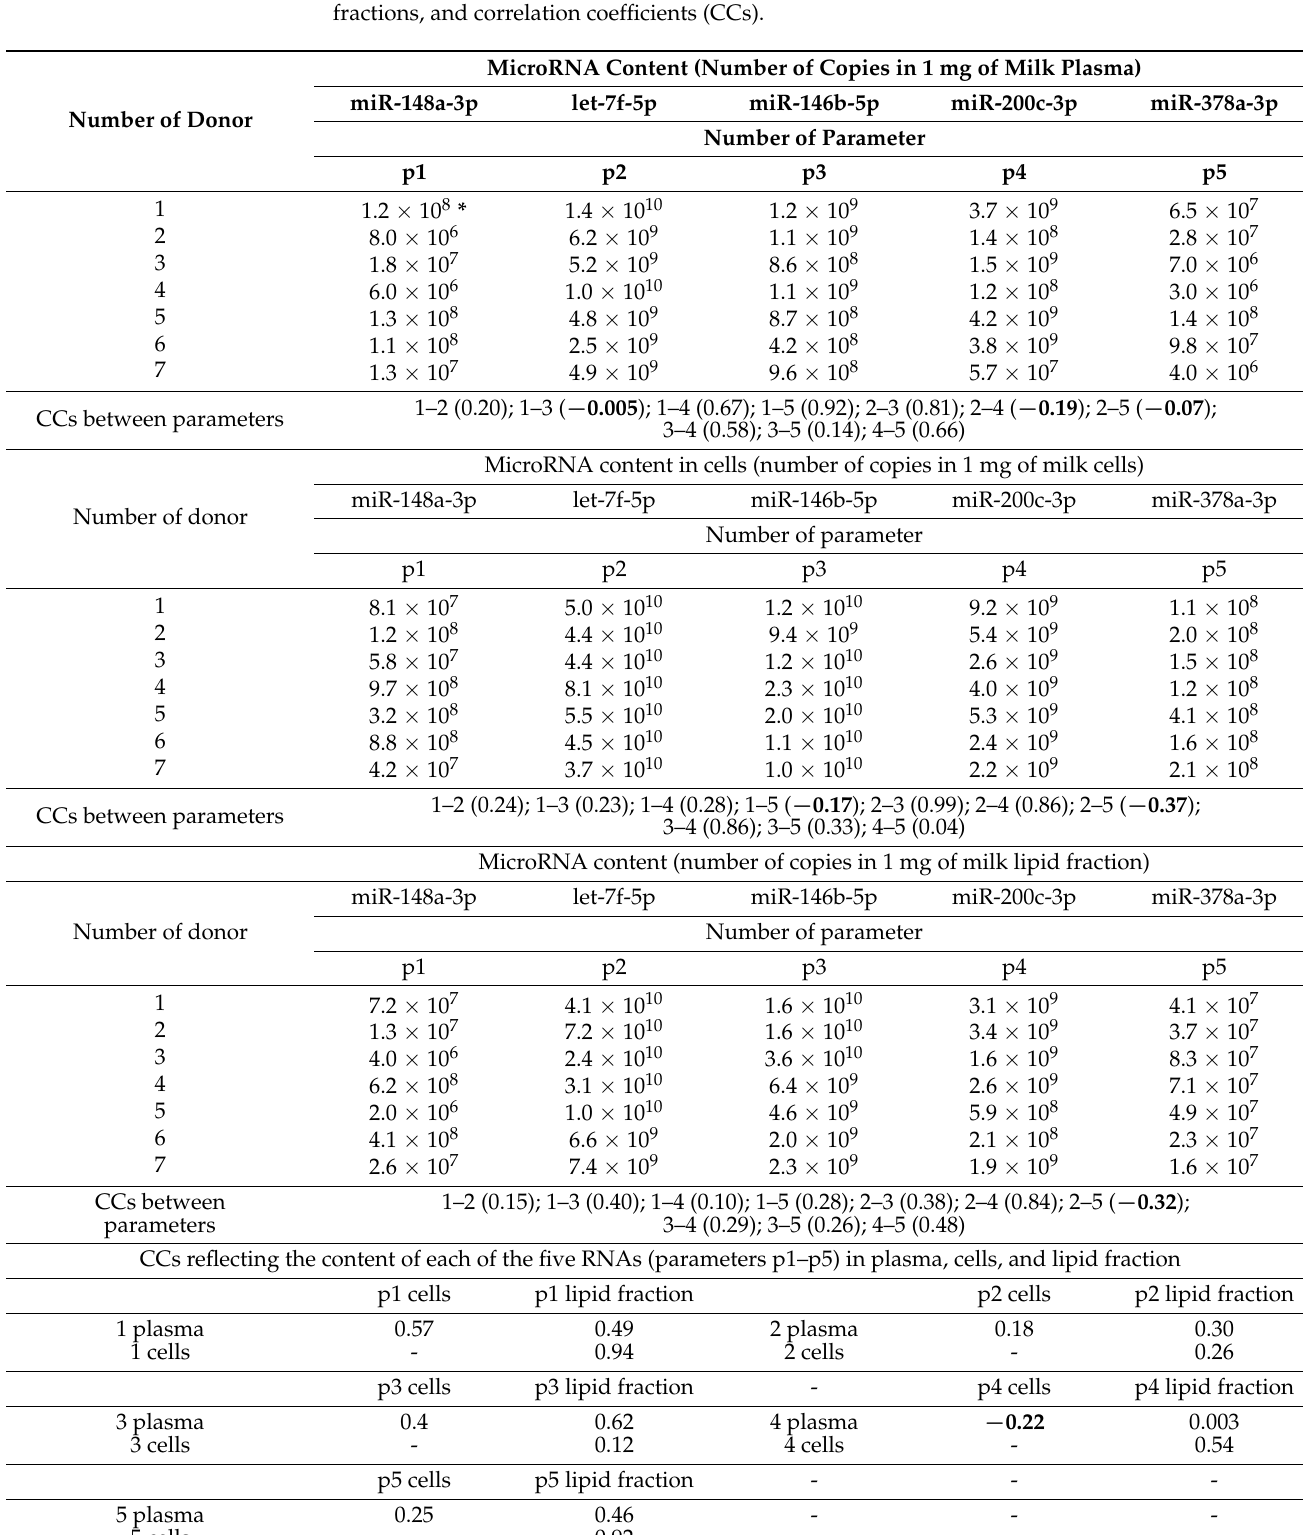
Table 1. MicroRNA content in 1 mg of individual preparations of milk plasma, cells, and lipid fractions, and correlation coefficients